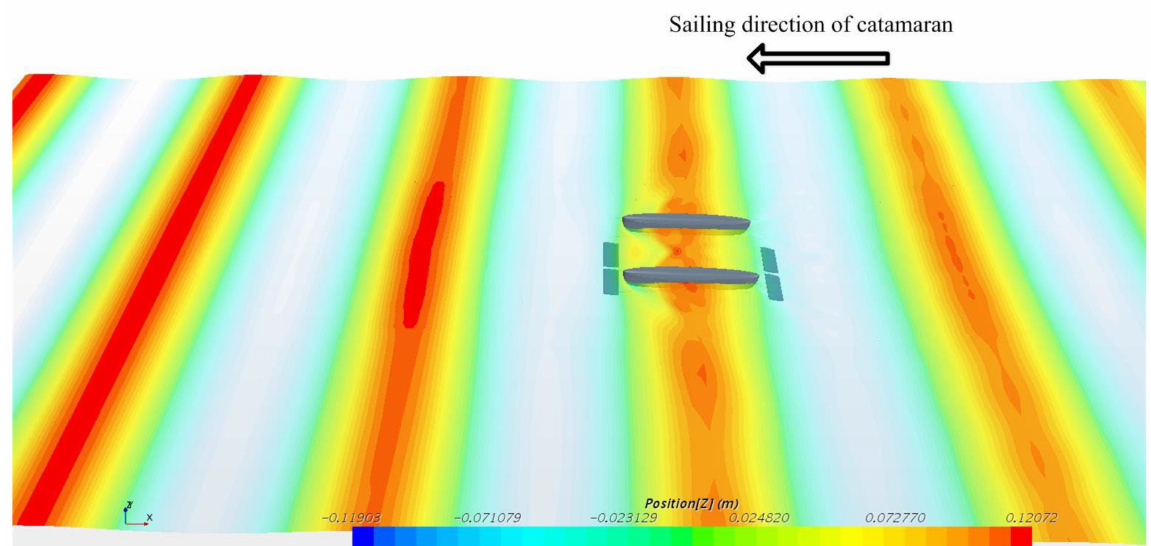
Figure 7. Self-propulsion diagram of wave-driven catamaran when wave height is 0.25 m and wavelength is 8